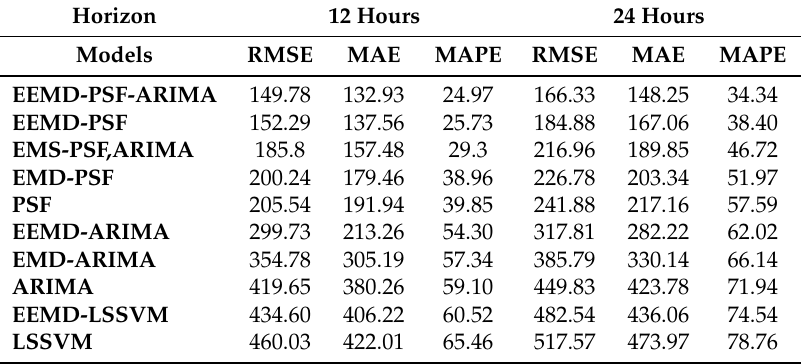
Table 4. Comparison of proposed methods with reported methods on RMSE, MAE and MAPE for horizon prediction (direct strategy) of 12 and 24 h with wind power